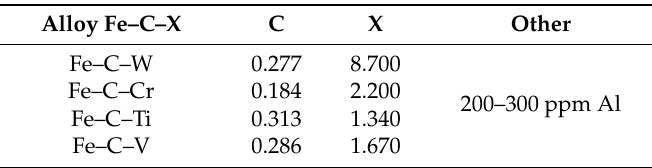
Table 1. Chemical composition of the different alloys in